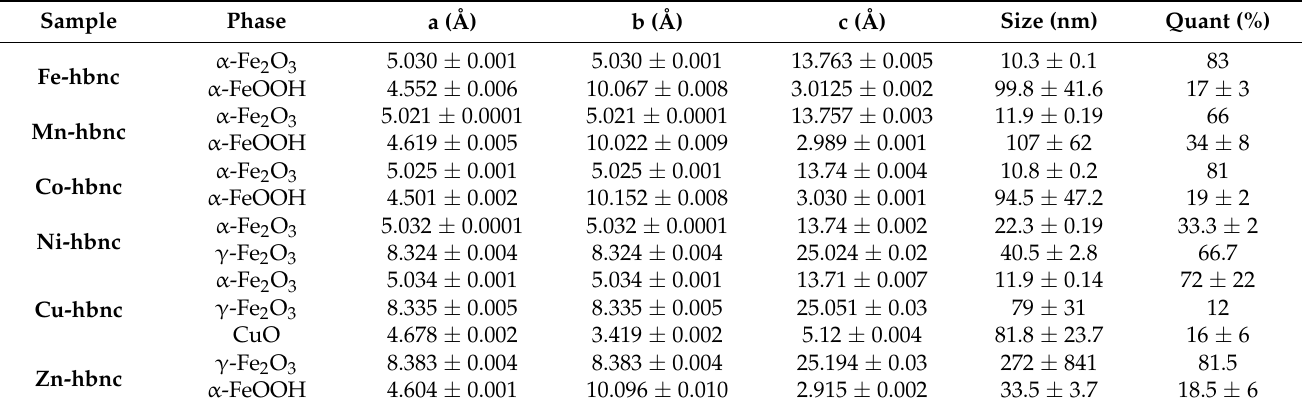
Table 3. Results of Rietveld analysis performed with MAUD software on XRD